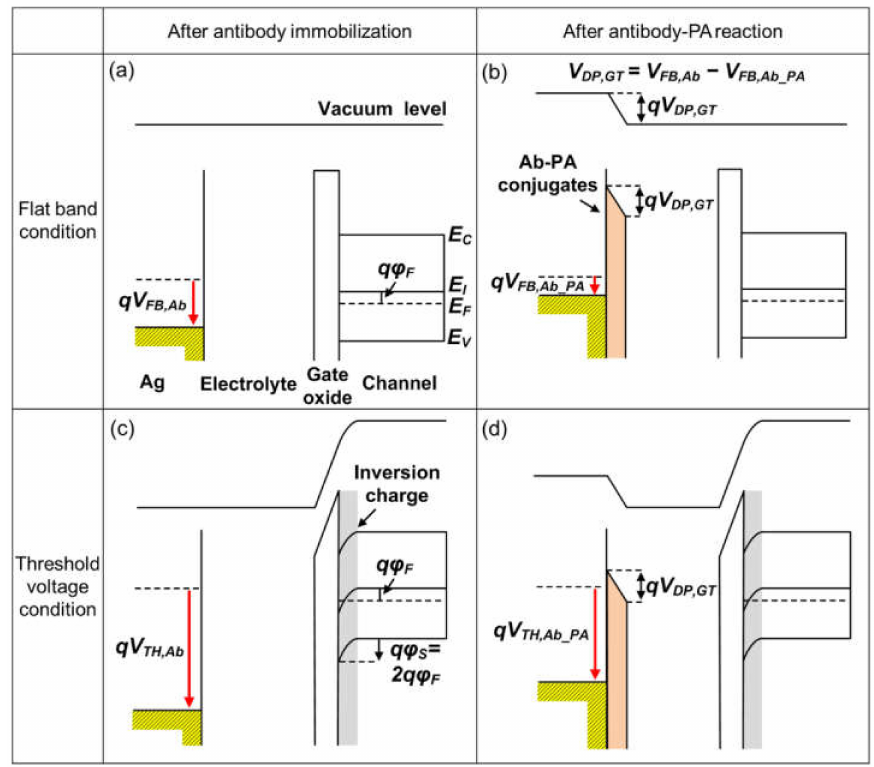
Figure 9. ( a – d ) Energy band diagrams of EGTs after antibody immobilization and after antibody–PA reactions under flat band conditions ( V G = V FB , ϕ S = 0) and threshold voltage conditions ( V G = V TH , ϕ S = 2 ϕ F